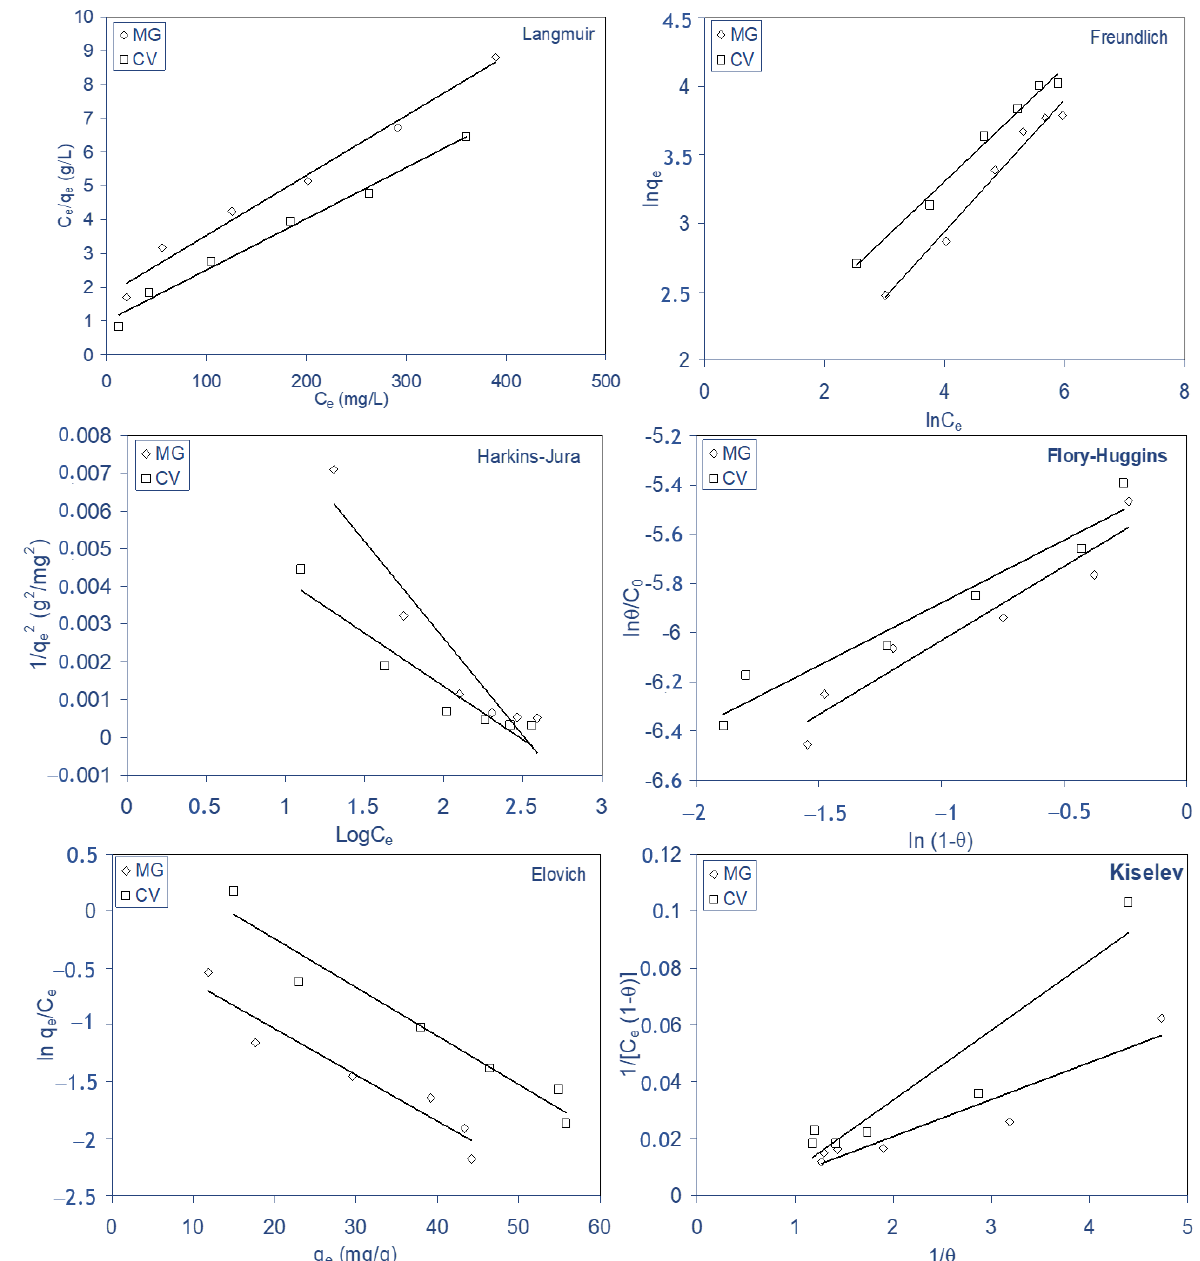
Figure 10. Linear plots of isotherm models for the biosorption of MG and CV on ALP: Langmuir,